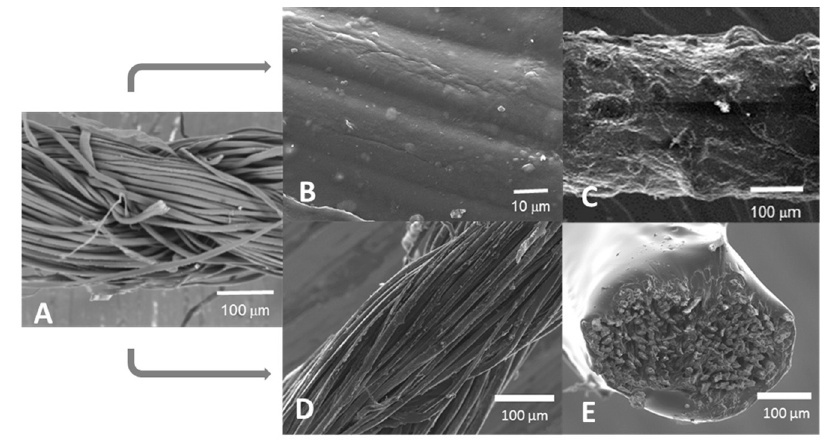
Figure 1. SEM images of cotton thread ( A ), PEDOT/MWCNT-cotton ( B ), Pani-coated PEDOT/MWCNT-cotton ( C ), SWCNT-cotton ( D ), cotton-based Li+ sensor ( E ).